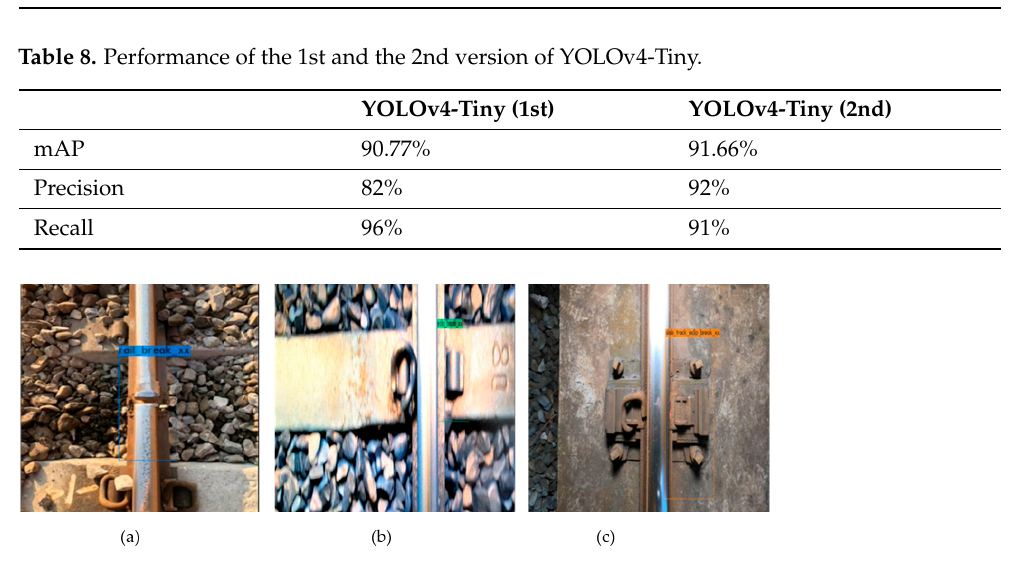
Table 10. YOLOv4 ‐ Tiny training results for each defective type in the top view.